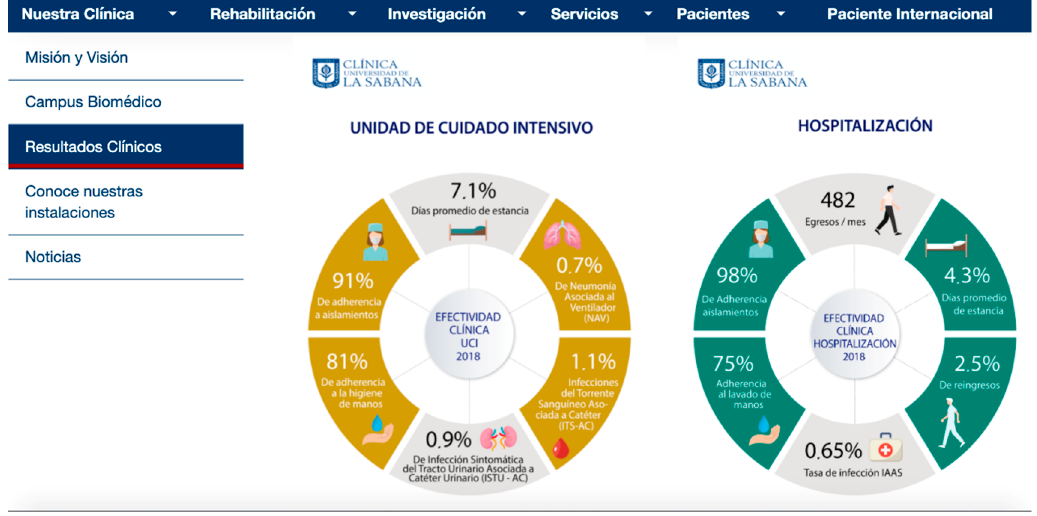
Figure 5. Open and data content of the “Clínica Universidad de la Sabana” (Colombia).